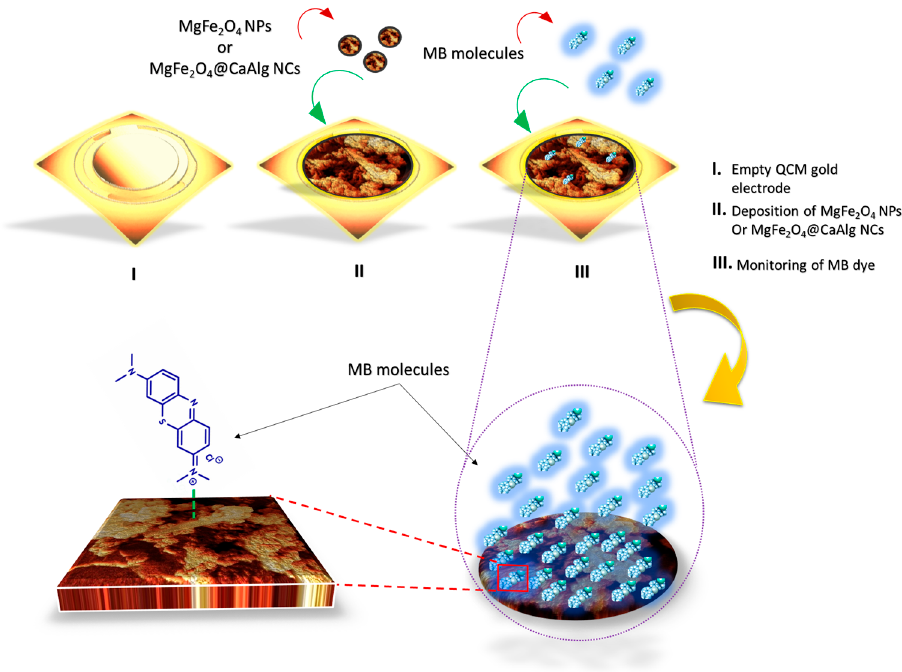
Figure 8. Illustrates the schematic exemplification for the hypothesized interaction mechanism be- tween the QCM-based MgFe 2 O 4 NPs or MgFe 2 O 4 @CaAlg NCs nanosensors and MB